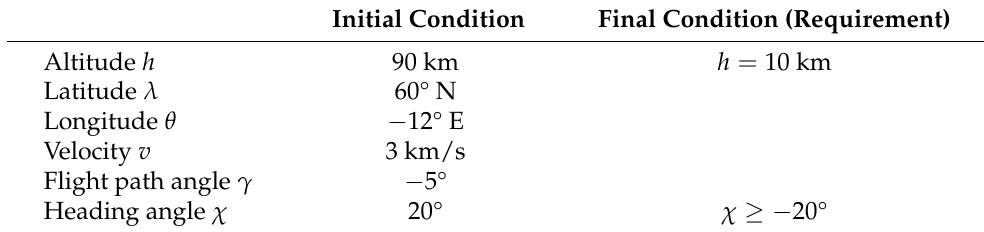
Table 1. Values and constraints on the boundary values of the state